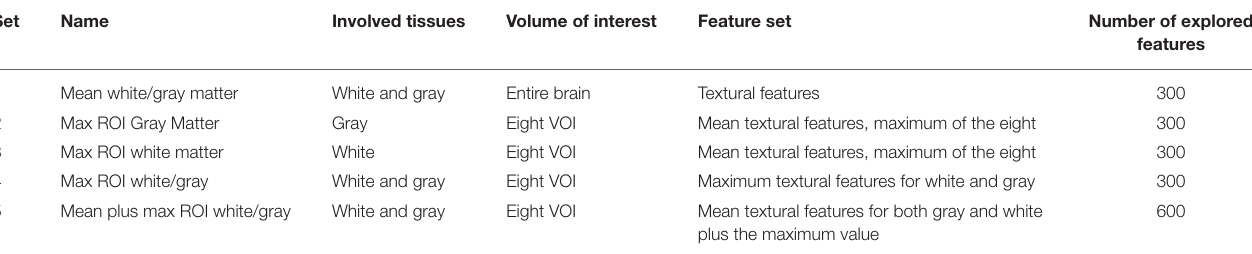
TABLE 1 | The five sets of